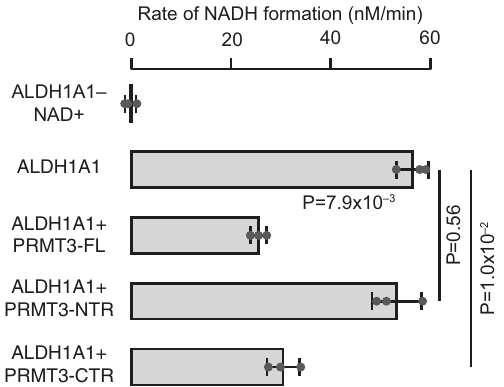
quanti fi ed luciferase activity of retinoic acid response element (RARE) — luciferase reporter expression construct in HEK293